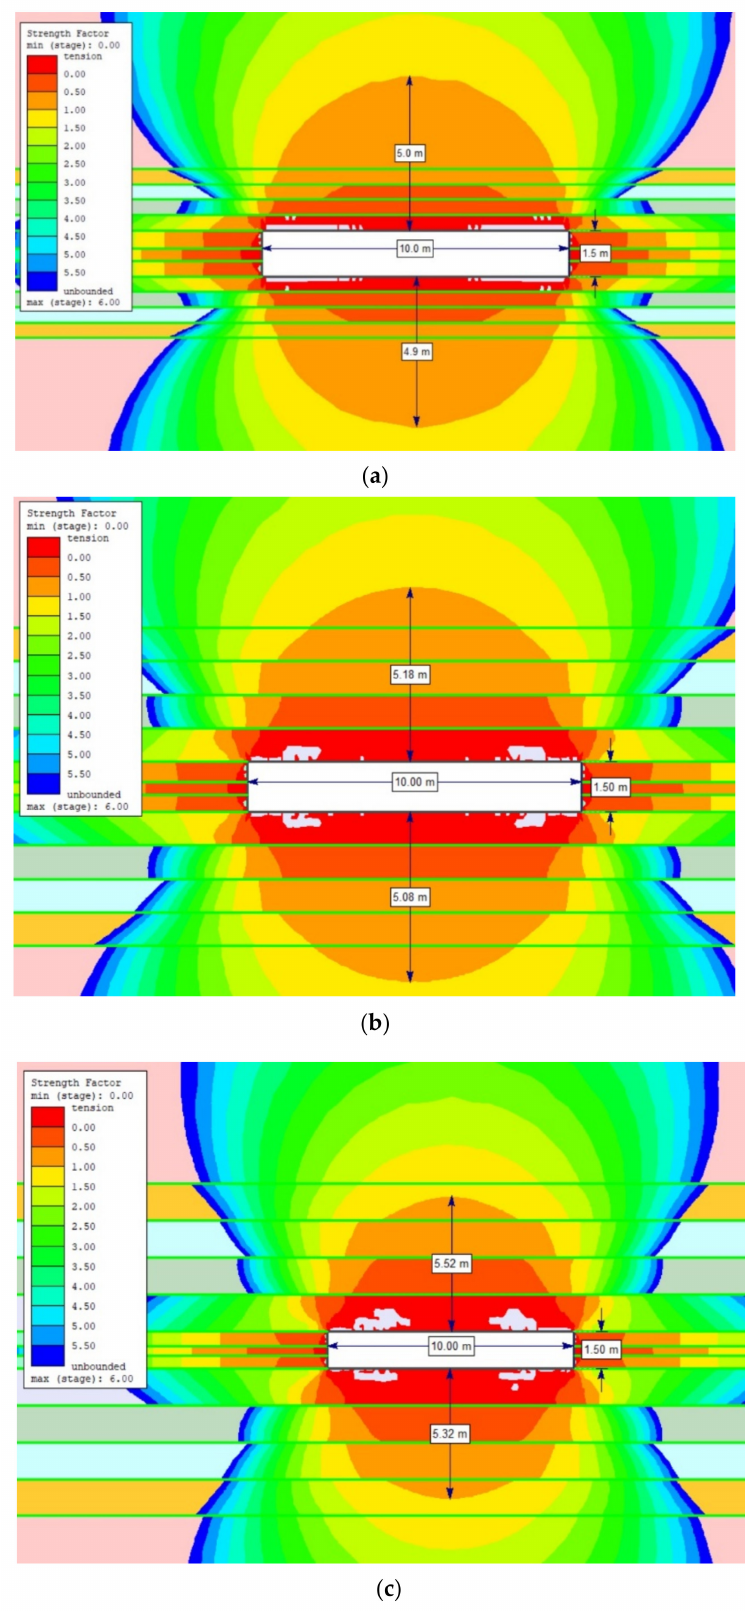
Figure 13. The extent of the rock destruction zone around the gasification channel with a width of 10 m and the impact of temperature of 1200 ◦ C for the wet rock mass, up to the height of: ( a ) 0.5 m; ( b ) 1.0 m; ( c ) 1.5